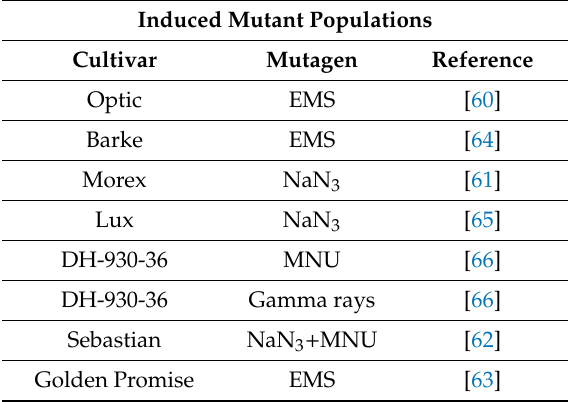
Table 3. List of representative barley mutant populations obtained by either chemical or physical mutagenesis in di ff erent genetic backgrounds, i.e.,